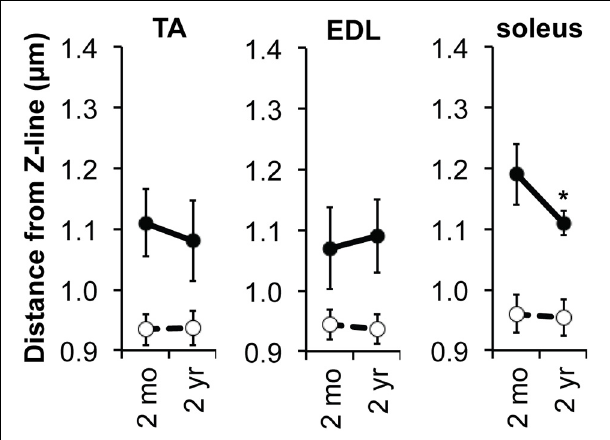
FIGURE 3 | Thin filament lengths in aged mouse muscles. Graphs depict distances of Tmod (solid circles) and nebulin M1M2M3 (open circles) from the Z-line in TA, EDL, and soleus muscles from 2-mo-old to 2-yr-old mice. Tmod distance reflects the variable position of the thin filament pointed end with respect to the Z-line, indicative of variations in length, while nebulin M1M2M3 distance reflects the relatively constant position of the proximal/distal segment boundary of the thin filament with respect to the Z-line (Gokhin and Fowler, 2013). Tmod distances reflect pooled Tmod1 and Tmod4 distances. Error bars reflect mean ± SD for n ≥ 100 myofibrils/time-point for Tmod, n ≥ 50 myofibrils/time-point for nebulin M1M2M3. ∗ p < 0 . 01 with respect to the previous